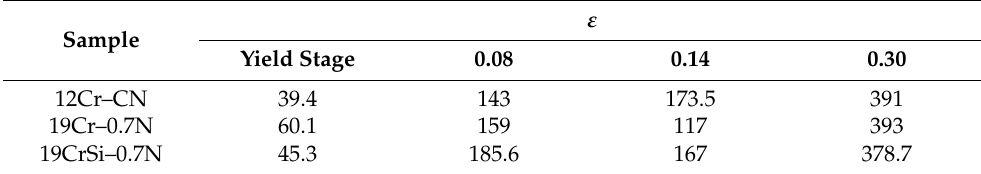
Table 5. Dislocation increment stress under different true strains